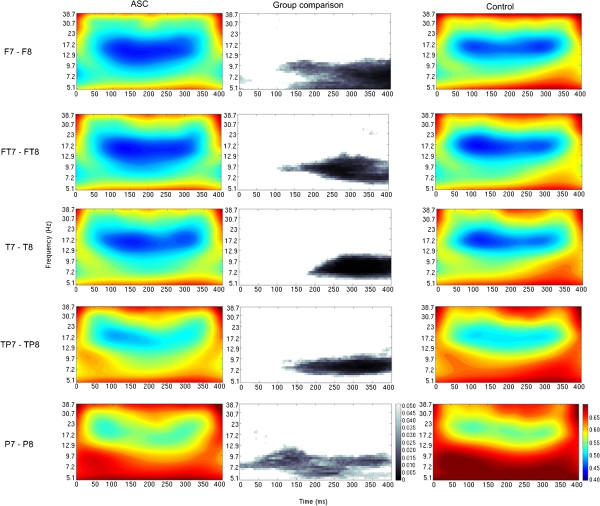
Mann–Whitney group comparison of interhemispheric coherence for the faces task (uncorrected P-values). The colored graphs represent values of wavelet coherence for the ‘faces’ task, for every time-frequency point and for each group (ASC: left column, controls: right column) and each pair of electrodes (different rows); areas in blue represent regions of low coherence in the time-frequency spectrum, while areas in red represent regions of high coherence. The graphs in the middle column represent the statistical group comparison for each electrode pair; areas shaded gray represent regions of the time-frequency spectrum where there is a significant decrease of coherence for the ASC group compared to the control group, at Puncorrected <0.05. No areas were found where there was a significant increase in coherence for the ASC group compared to the control group.